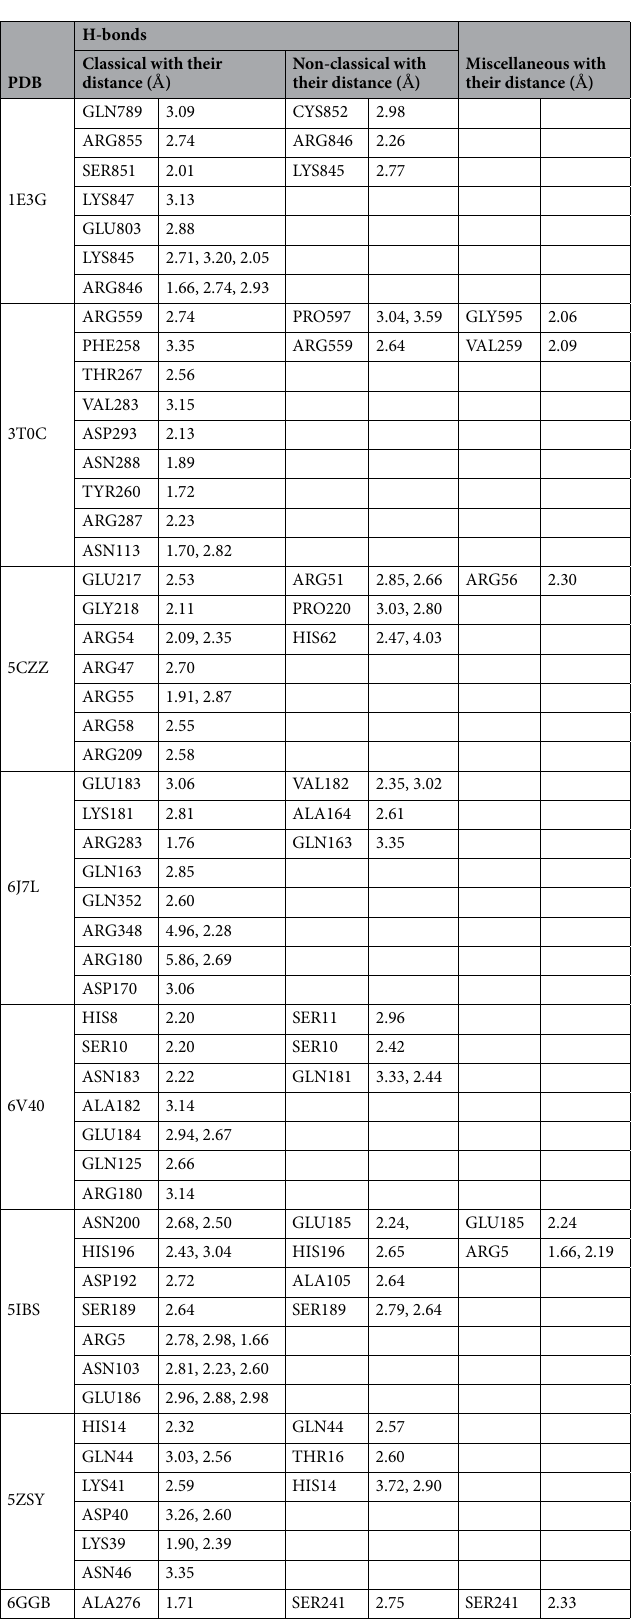
Table 4. Interactions (hydrogen bonding and others) of pectin with different